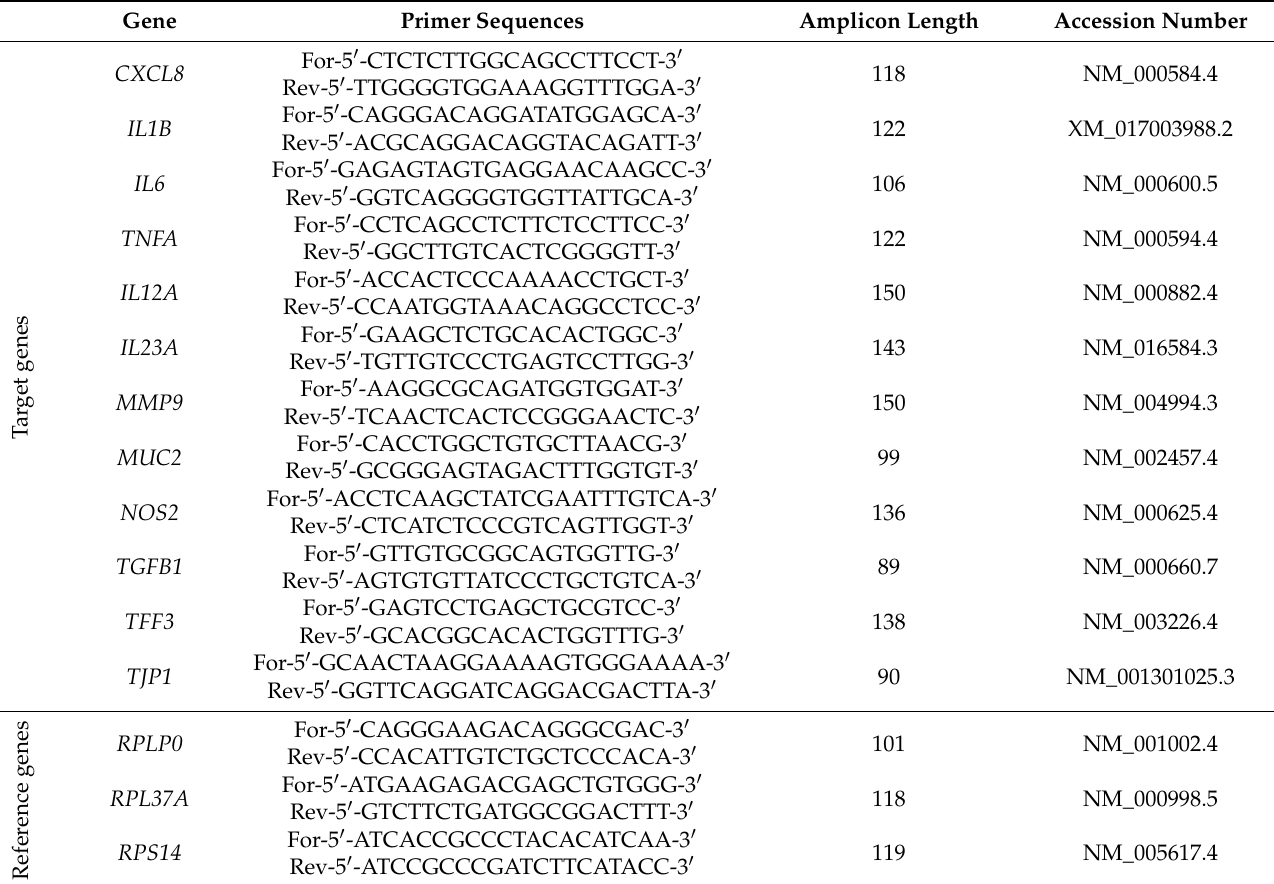
Table 1. Primer set sequences for target genes and